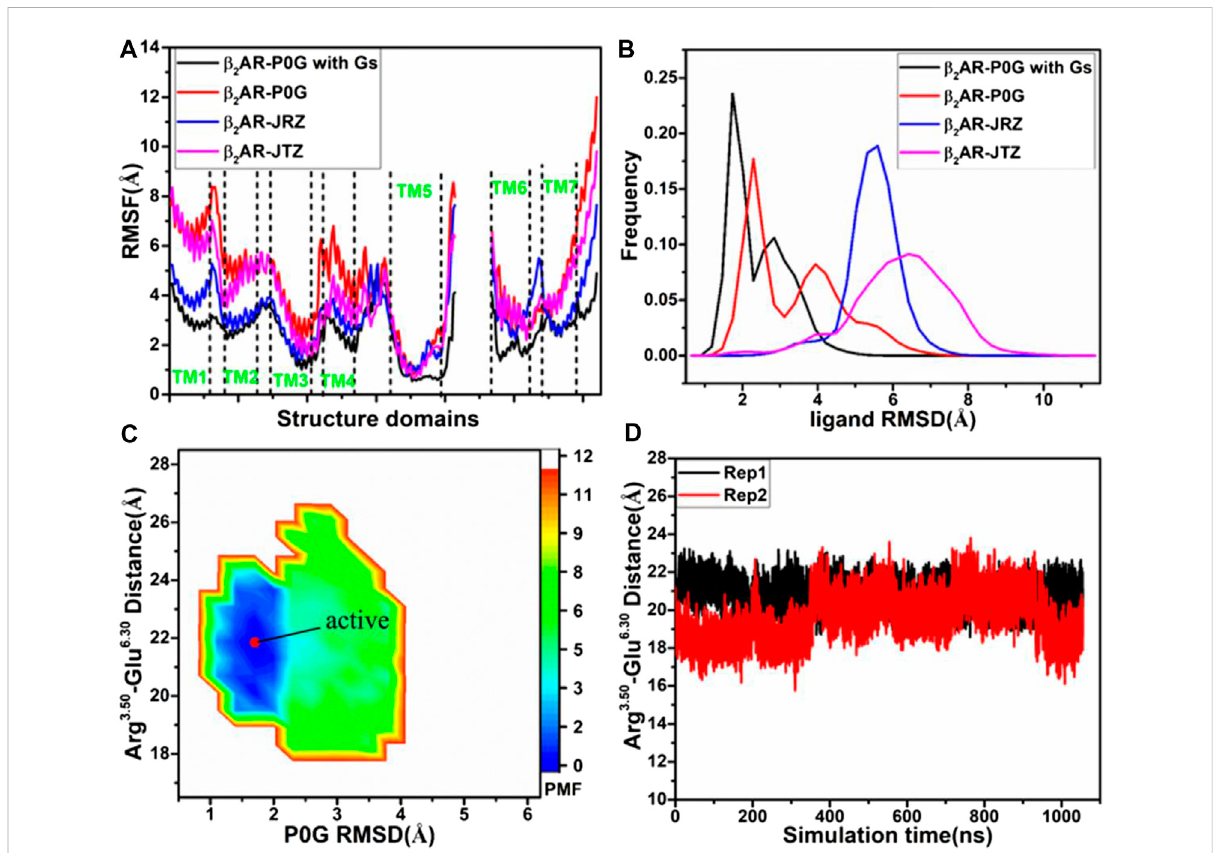
FIGURE 1 Structural fl uctuationandfreeenergyinformation: (A) RMSFsoftheC α atomsfrom β 2 ARinfoursimulatedsystems, (B) RMSDsofnon-hydrogen atoms from P0G, JRZ, and JTZ in four simulated systems, (C) free energy landscape of the P0G-bound β 2 AR with the Gs protein constructed using thedistancesbetweentheC α atomsofresiduesArg 3.50 andGlu 6.30 andtheRMSDofP0G,and (D) theevolutionofthedistancebetweentheC α atoms of residues Arg 3.50 and Glu 6.30 as the simulated time. PMF is scaled in